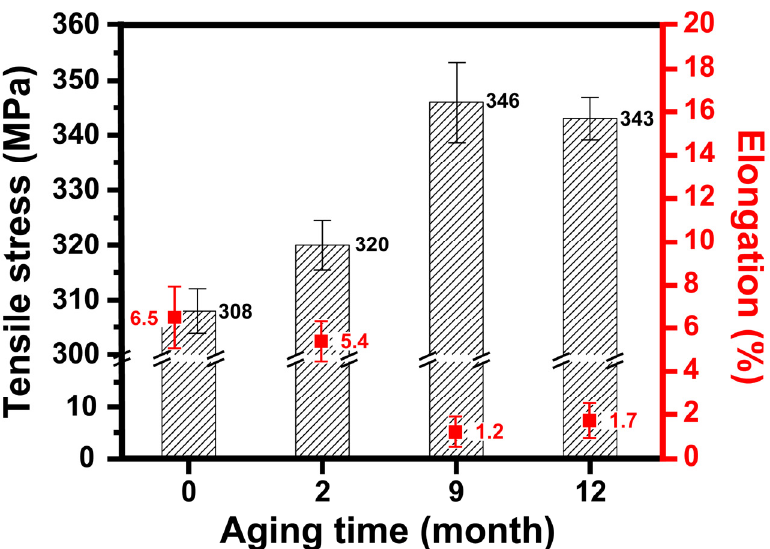
Figure 1. Fracture strength and elongation of Al-20Zn-3Cu with respect to the natural aging time for the as-cast sample and those at 2 months, 9 months, and 12 months. the as-cast sample and those at 2 months, 9 months, and 12